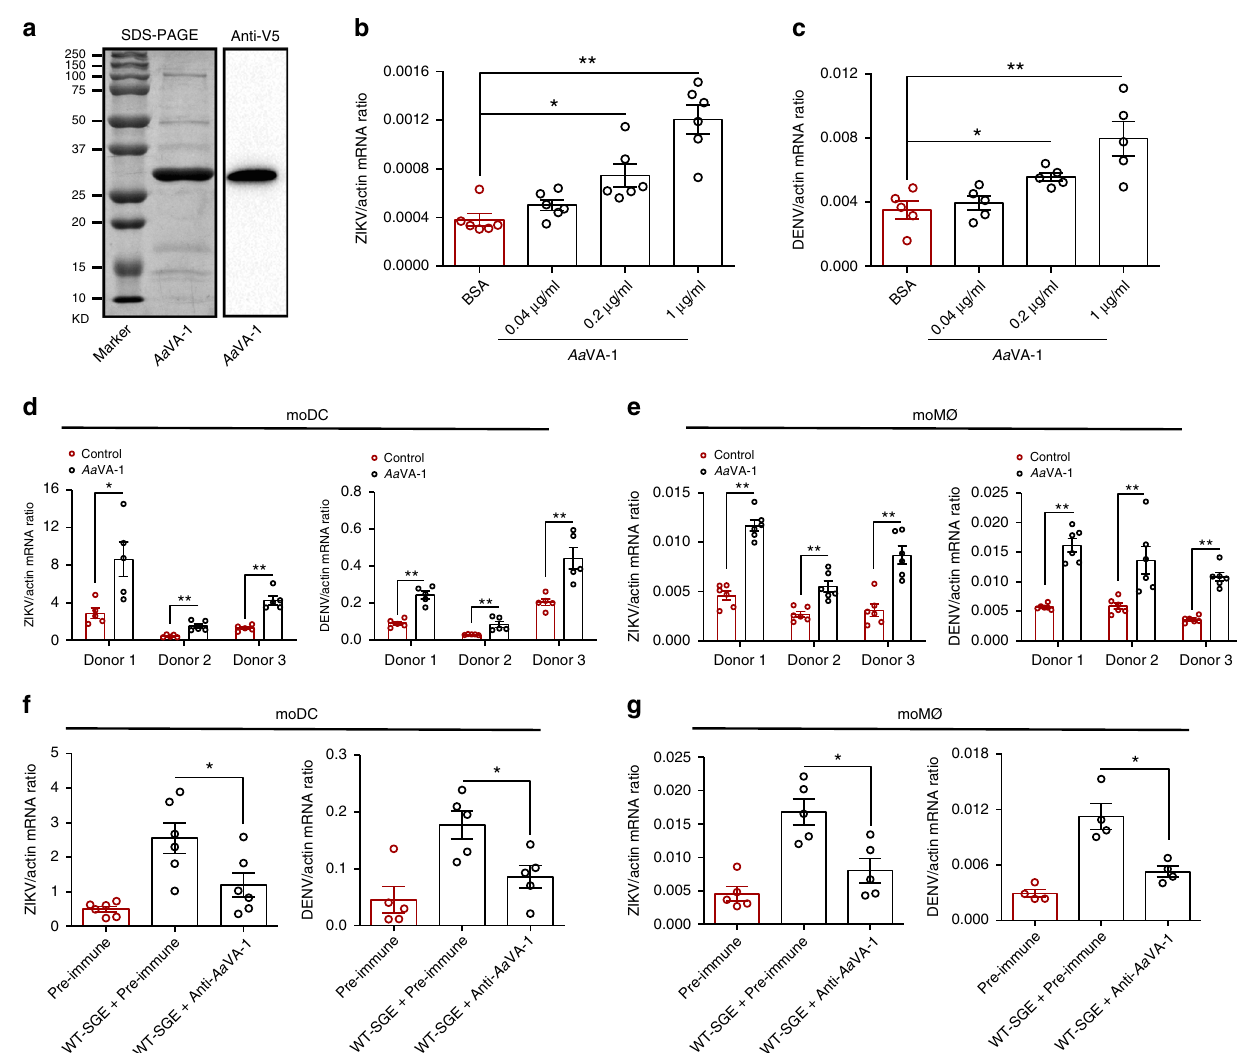
Fig. 2 Aa VA-1 promotes fl aviviral infection in human monocyte-lineage cells. a Expression and puri fi cation of Aa VA-1 using a Drosophila expression system. The Aa VA-1 gene was cloned into the pMT/BiP/V5-His A expression vector. Recombinant Aa VA-1 was expressed and puri fi ed using a Cobalt-His column (left panel). Expression was probed using anti-V5 antibody (right panel). The experiments were repeated three times with the similar results. b , c Incubation of Aa VA-1 puri fi ed protein facilitated ZIKV ( b ) and DENV ( c ) infection in THP-1 cells. The infected cells were detected at 24 h postinfection by qRT-PCR. BSA was incubated with the viruses as a mock control. b n = 6 independent samples. c n = 5 independent samples. d , e Incubation of Aa VA-1 enhanced the replication of ZIKV and DENV in human moDC ( d ) and moMØ ( e ). The same amount of BSA served as a negative control. d n = 5 independent samples. e n = 6 independent samples. f , g Immuno-blockade of Aa VA-1 by a murine polyclonal antibody restored the WT-SGE-mediated viral enhancement in human moDC ( f ) and moMØ ( g ). Pre-immune sera mixed with SGE served as a mock control. f n = 6 (ZIKV) or n = 5 (DENV) independent samples. g n = 5 (ZIKV) or n = 4 (DENV) independent samples. b – g Human cells were infected with ZIKV and DENV, respectively. The viral doses used in the infection were 0.1 MOI for THP-1, 0.5 MOI for moDC, and 0.1 MOI for moMØ. Gene quantities were normalized against human actin (NM_001101.4). The data are presented as the mean ± SEM. A nonparametric Mann – Whitney test was used for the statistical analysis. * p < 0.05, ** p < 0.01. The data were combined based on two independent experiments. Source data are provided as a Source Data fi